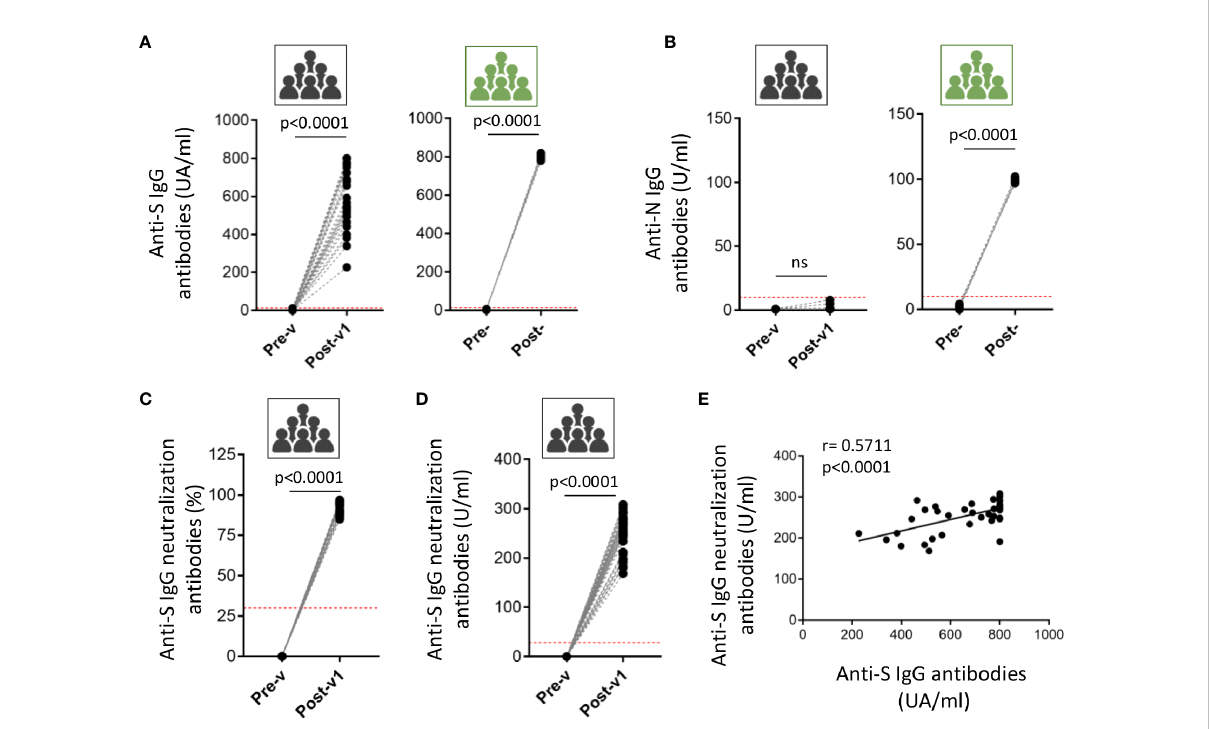
FIGURE 2 Induced humoral response in ICU workers after COVID-19 mRNA vaccination. The antibodies titer against full-length spike (S) protein (A) and nucleocapsid (N) protein (B) was quanti fi ed in serum samples from ICU workers (black icons) at times previous to vaccination (Pre-v) and one month after full vaccination (Post-v1), and from fi ve COVID-19 convalescent patients with severe disease (green icons) determined before (Pre-) and after (Post-) infection. Neutralizing antibodies were measured in serum samples from ICU workers (black icons) at times previous to vaccination (Pre-v) and one month after full vaccination (Post-v1) and data are represented as the inhibition percentage (C) and quanti fi ed by units per ml (U/ml) (D) . Red dotted-lines in panels (A-D) mark the limit of positivity. Statistical comparisons were performed by Wilcoxon test. (E) Correlation between frequencies of the titers of neutralizing and total anti-S IgG antibodies in ICU workers one month after full vaccination. Statistical by Spearman correlation coef fi cient. ns, not signi fi